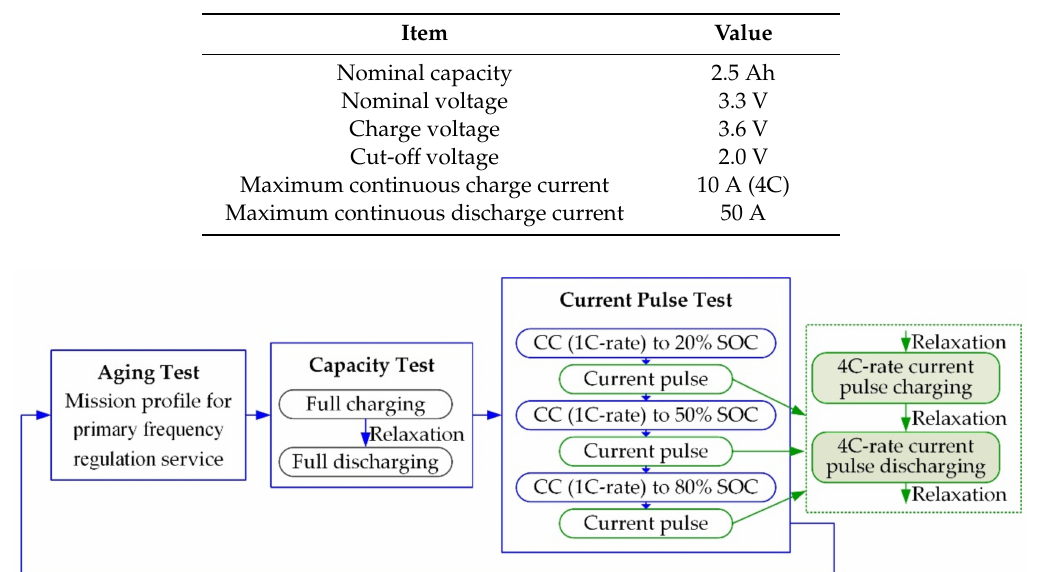
Table 1. The datasheet of the LiFePO 4 / C battery.